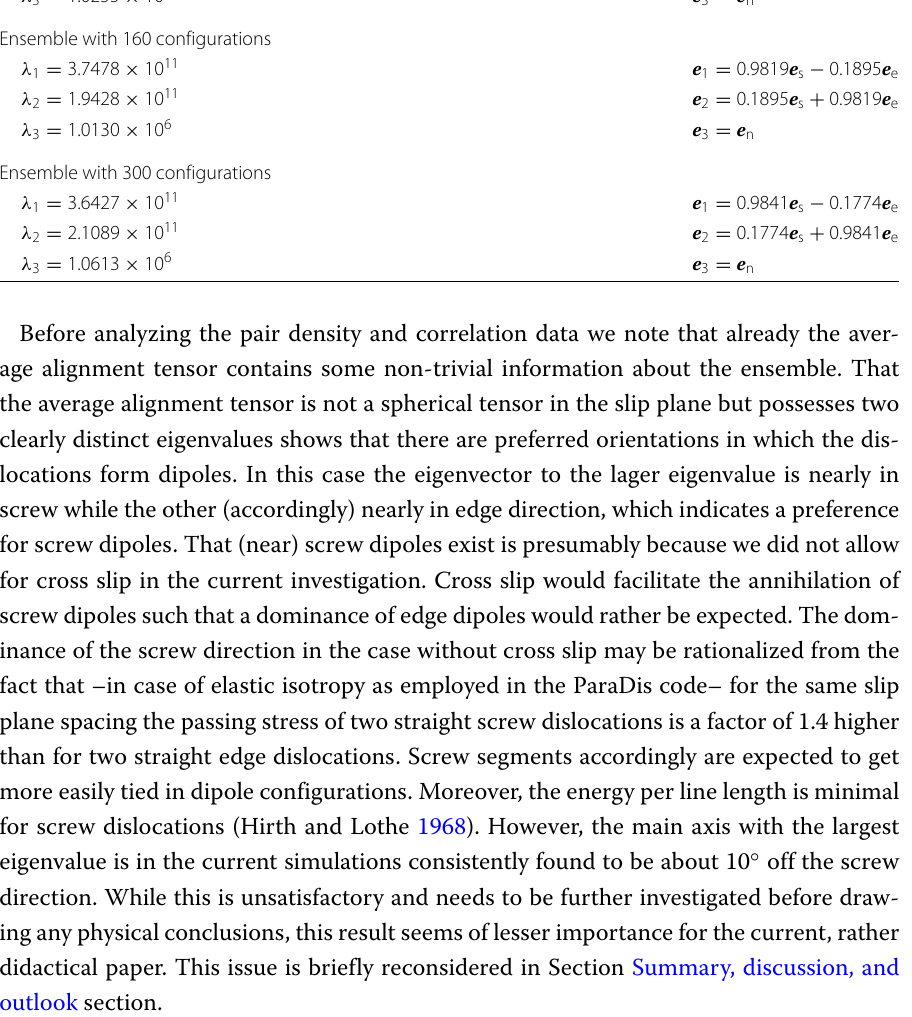
Table 2 Eigenvalues and eigenvectors of averaged second order alignment tensors obtained using ensembles with increasing number of configurations (presented in the slip system coordinate) Eigenvalue Eigenvector Ensemble with 10 configurations λ = 3.8835 × 10 11 e 1 λ = 2.3082 × 10 11 e 2 λ = 8.7028 × 10 5 e 3 Ensemble with 20 configurations = 3.7984 × 10 11 e λ 1 Ensemble with 40 configurations λ = 3.7104 × 10 1